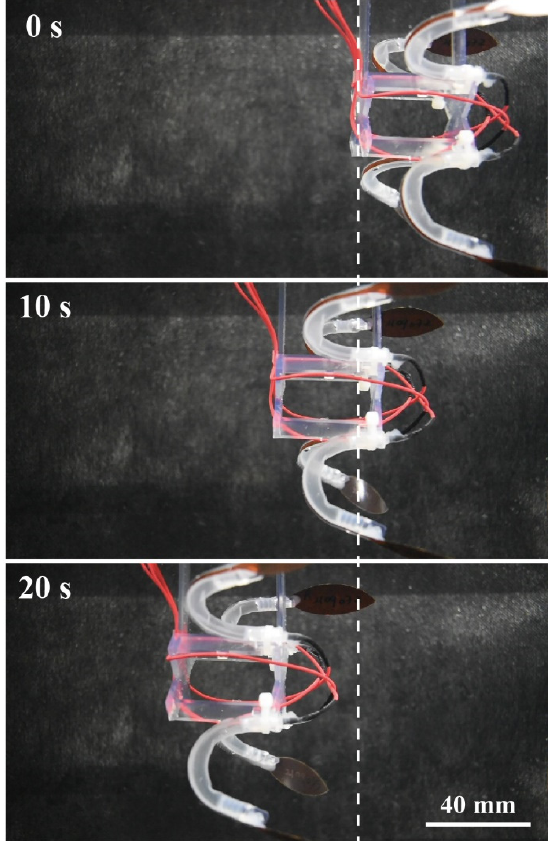
Figure 5. Swimming sequence of the jellyfish-type underwater robot driven at 10 kV and 4 Hz.